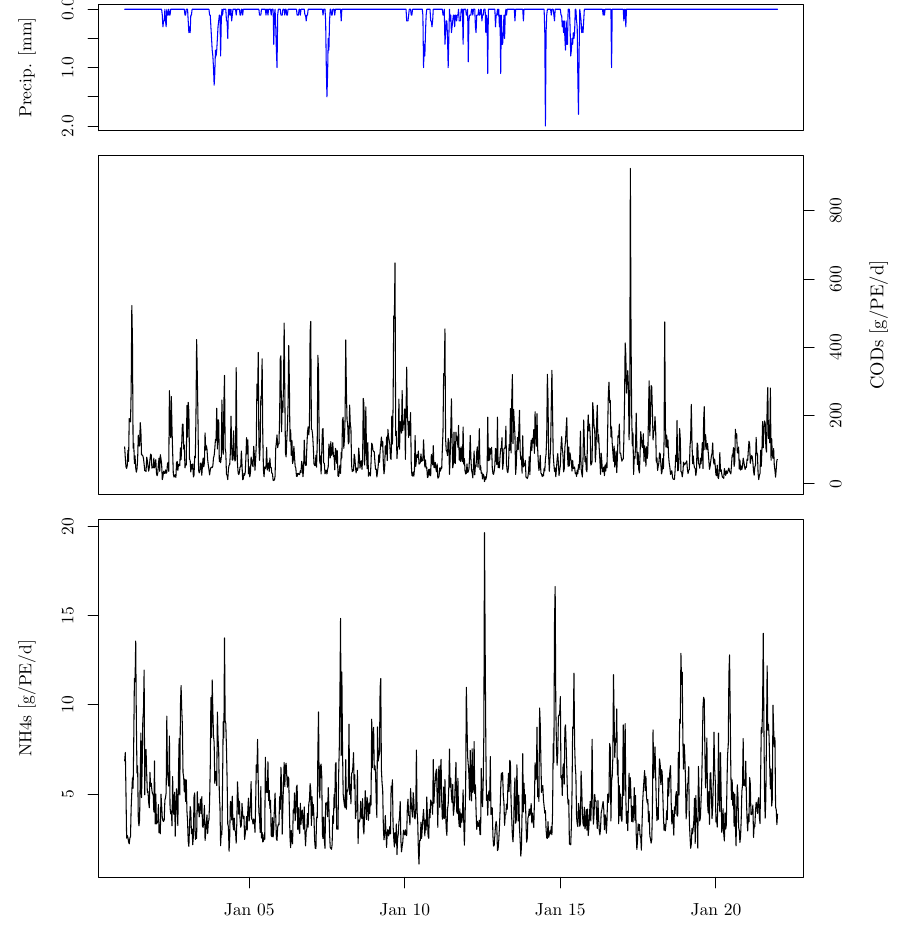
Figure 2. Series of precipitation, sewage COD pollution and sewage NH 4 pollution for the time